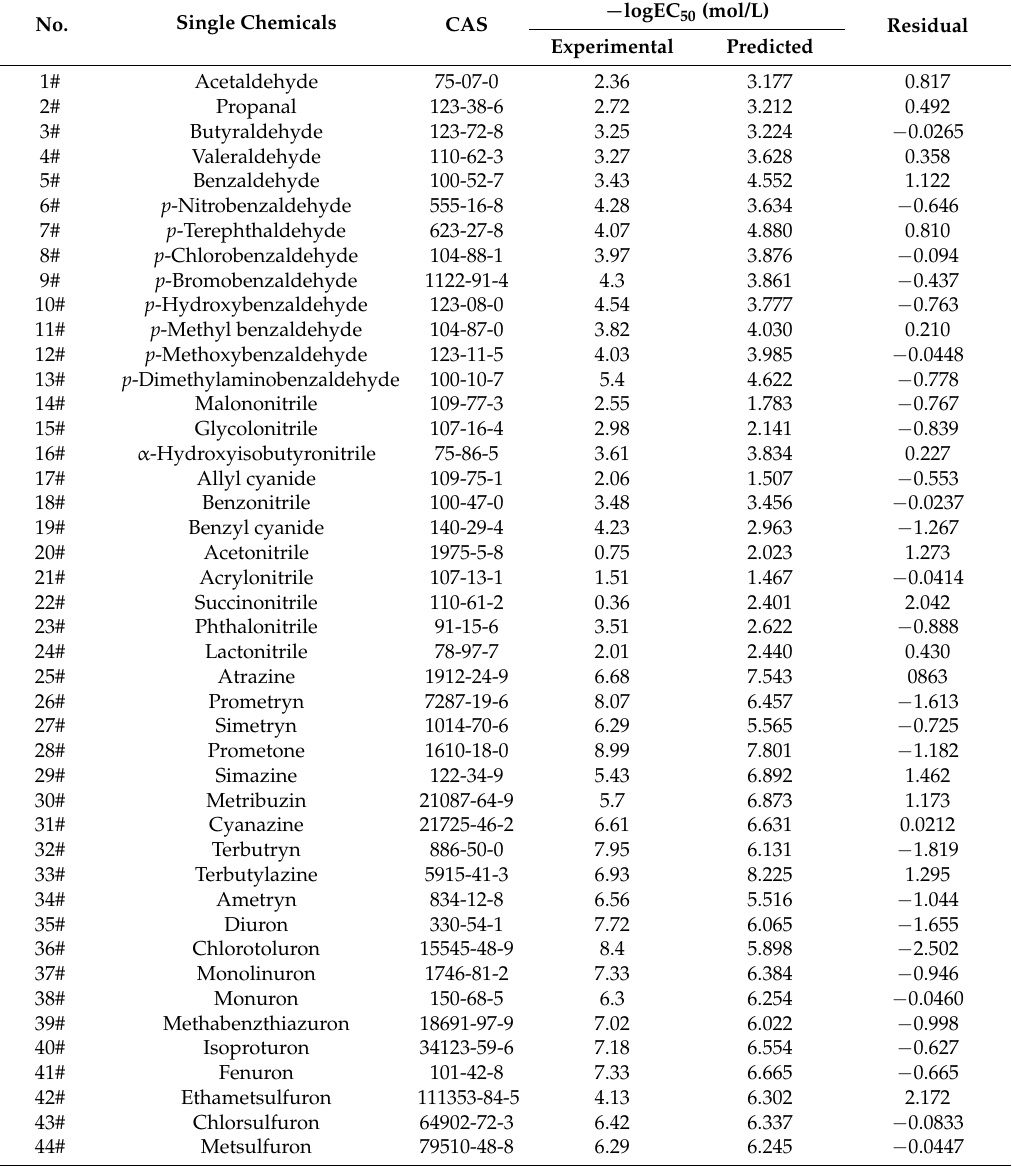
Table 1. Toxicity data of the single